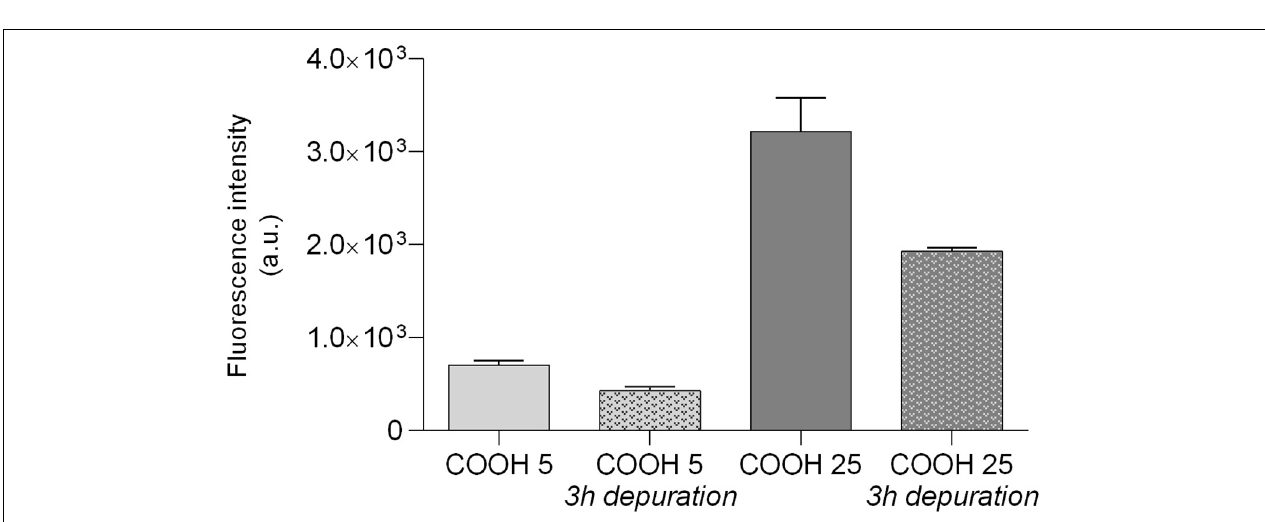
FIGURE 7 | PS-COOH elimination from sea urchin coelomocytes. Fluorescence intensity (arbitrary units, a.u.) of lysates of coelomocytes exposed for 1 h to PS-COOH (5 and 25 µ g mL − 1 ) and then left for 3 h in CF. Bars represent mean ± SD ( n = 3). Fluorescence intensity is normalized to the auto-fluorescence signal of cells exposed to CF